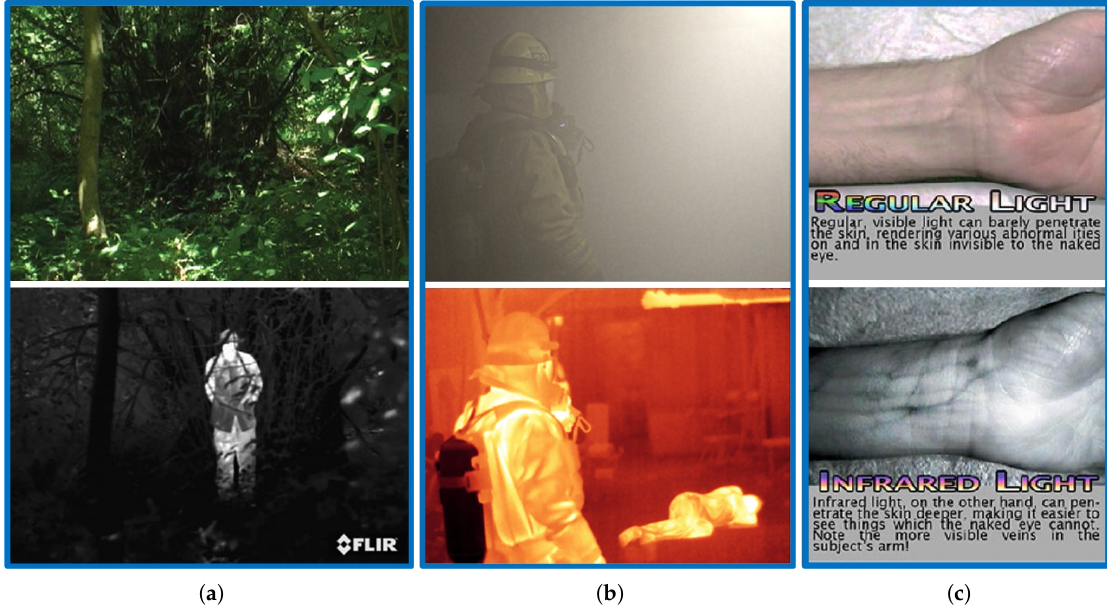
Figure 1. The effectiveness of using IR imaging compared to normal imaging in some real applications: ( a ) Surveillance [9], ( b ) Fire fighting [10], ( c ) Medical imaging